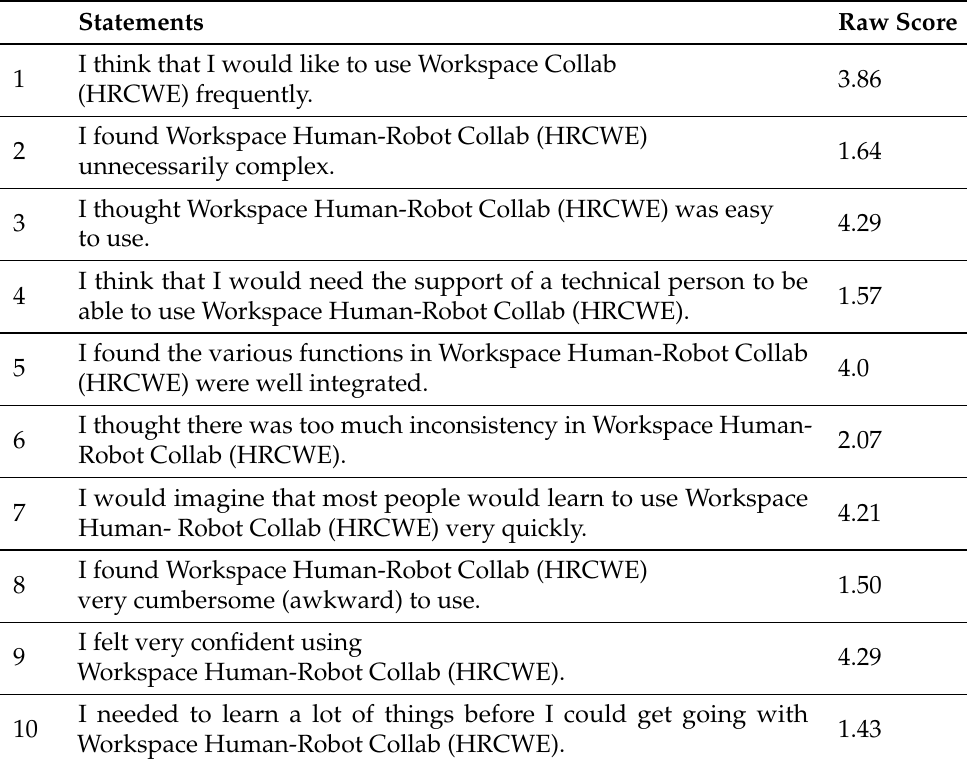
Table 5. Responses to individual statements of the